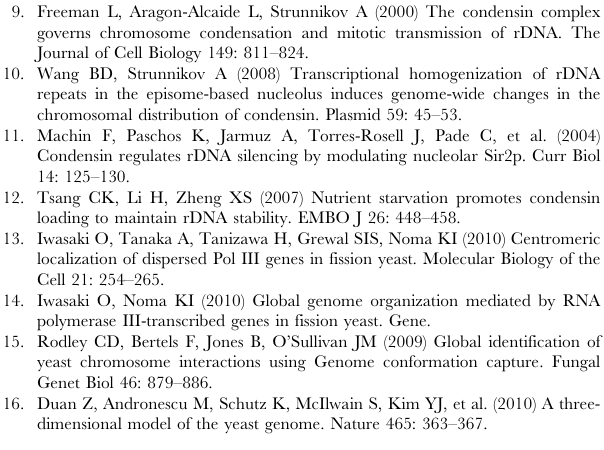
interactions were identified from interaction networks produced by analysis of Genome Conformation Capture (GCC) libraries constructed using the MspI restriction enzyme and chromatin from glucose grown S. cerevisiae cells (Methods S1). Only data which occurs above the experimental noise threshold has been included (see Supplementary Statistics in Methods S1). These tables do not contain adjacent interactions as they are not included in the statistical calculations. Table S2 SUP4-1 directed interactions detected by circularized chromosome conformation capture (4C). Captured "prey" fragments whose coordinates are outlined in columns F, G and H are listed alongside the 4C bait fragments (which contain either the wildtype tL(UAA)B2, tL(CAA)G3 loci, or these loci replaced with a SUP4-1 sequence) with which they interact. Only interactions which are conserved by the presence of the SUP4-1 sequence are present in this file. These interactions are conserved regardless of the genomic position of the SUP4-1 sequence. Table S3 Primer and probe sequences used in this study. Data S1 Comparison of interactions for wild-type and yDP77 strains. Topography v1.19 program output for the high throughput sequencing of the 4C PCR product. The complete data set is presented along with tabs in which